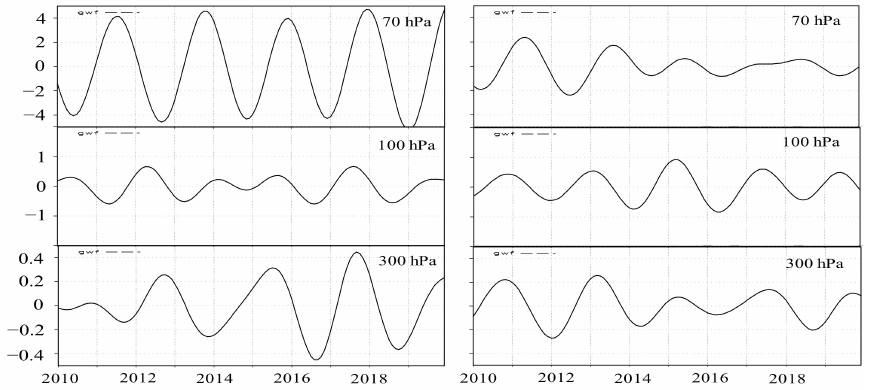
Figure 12. QBO components of GWFs at 70, 100, and 300 hPa for the ( left ) perpetual runs of January, and ( right ) from 2010 to 2019. All of the quantities are averaged between 10 ◦ S and 10 ◦ N. Units are in 10 − 2 ms − 1 day − 1